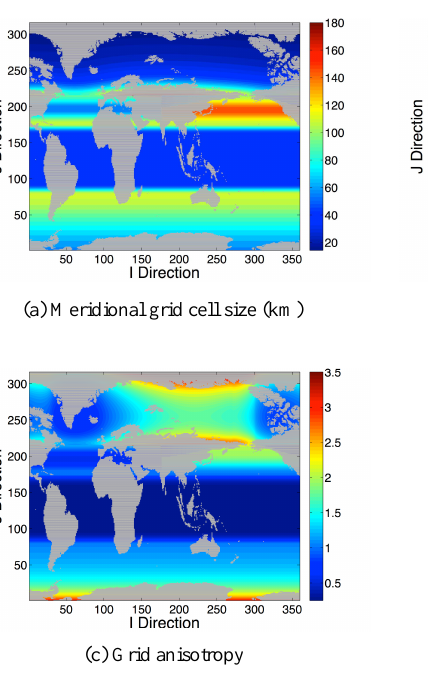
Figure 8. Scales of the 1 ◦ global grid with North Pole relocation.